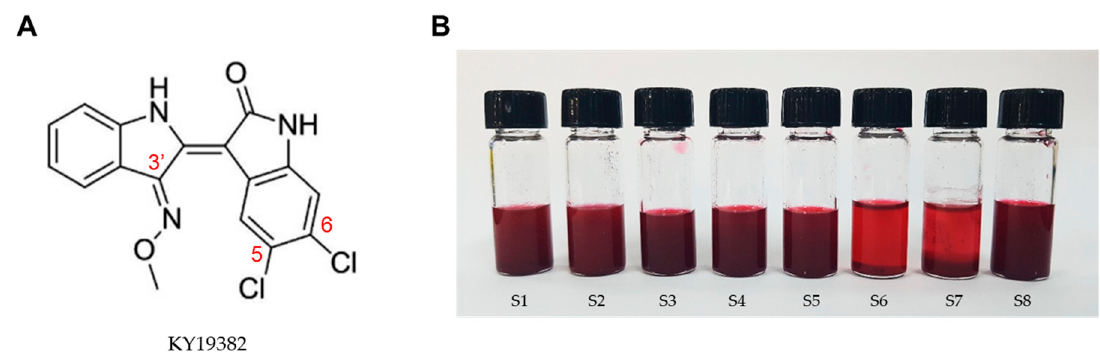
Figure 1. Characterization and solubilization of KY19382. ( A ) Chemical structure of KY19382. ( B ) Solubilization of KY19382 in various vehicles at 25 °C.